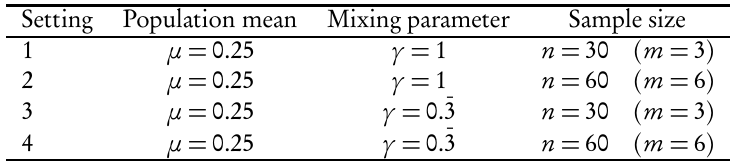
Different settings for model parameters Setting Population mean Mixing parameter Sample